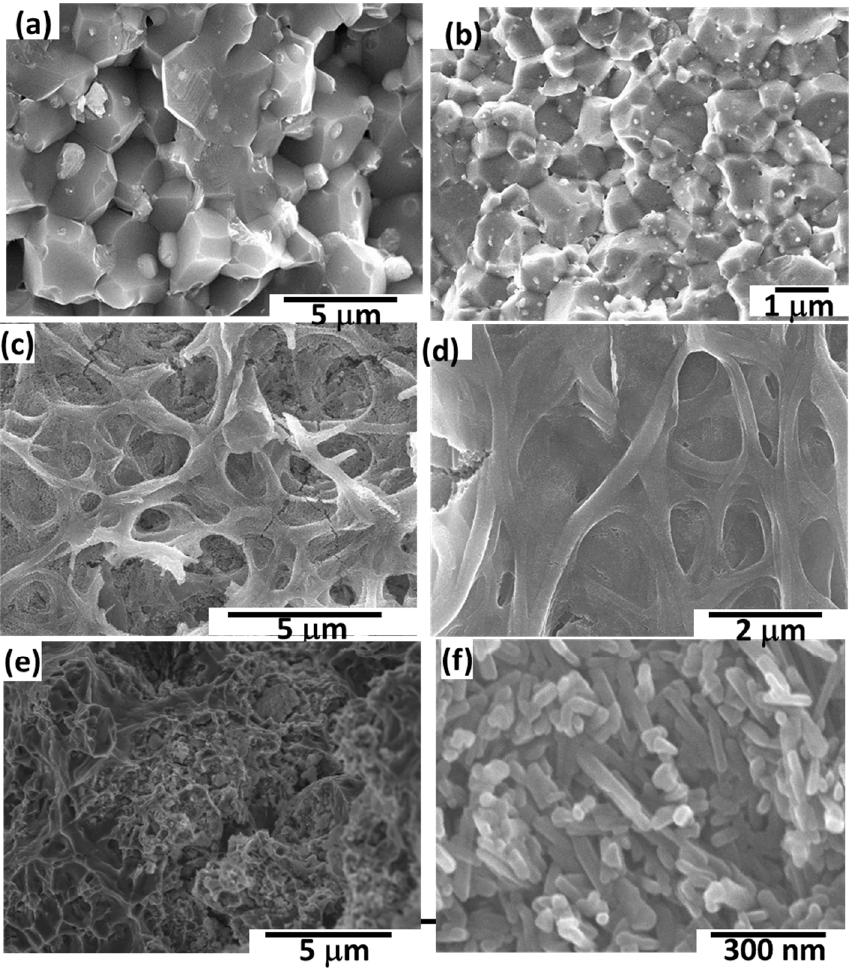
Figure 15. SEM micrographs of fracture surfaces of Al/TiC nanofibers composites: ( a ) Pure Al; ( b ) 1 wt % TiC; ( c ) 2 wt % TiC; ( d ) 3 wt % TiC; ( e ) 4 wt % TiC; ( f ) 5 wt % TiC.